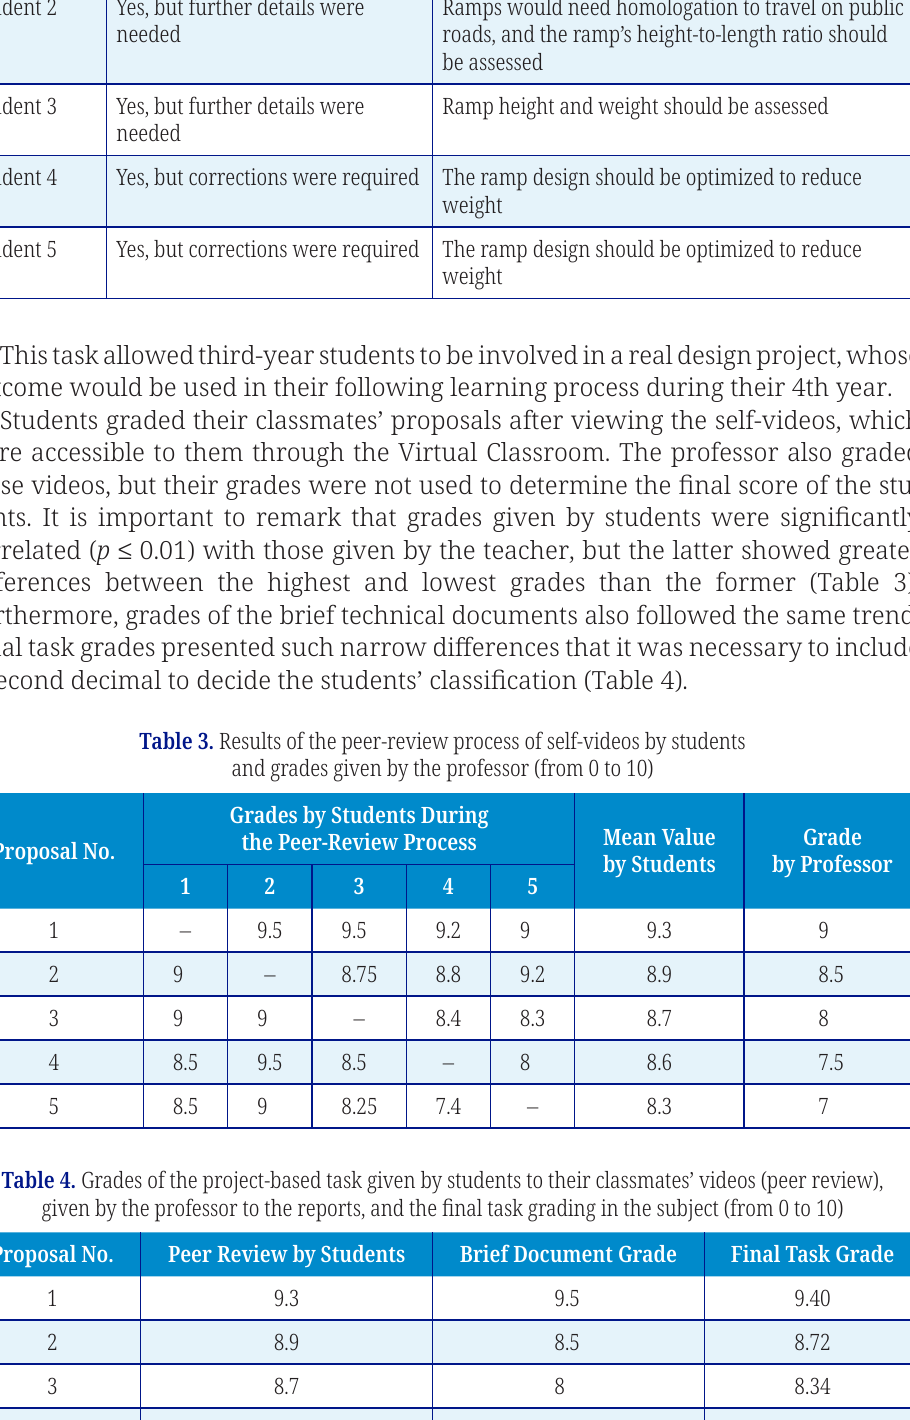
Table 4. Grades of the project-based task given by students to their classmates’ videos (peer review), given by the professor to the reports, and the final task grading in the subject (from 0 to 10) Proposal